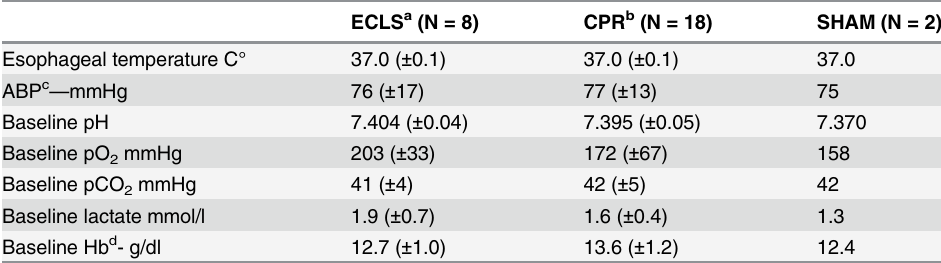
Table 1. Baseline